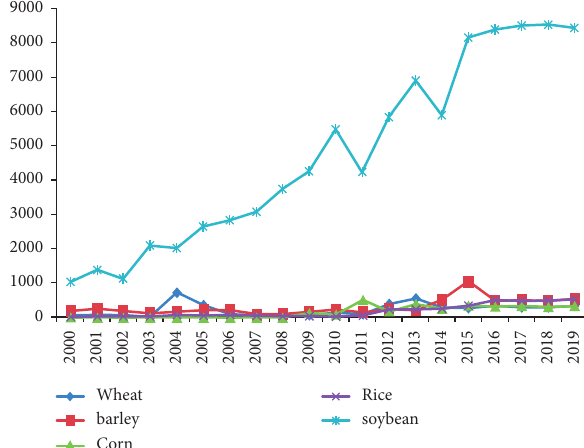
Figure 3: China’s major grain imports (unit: 10,000 tons).